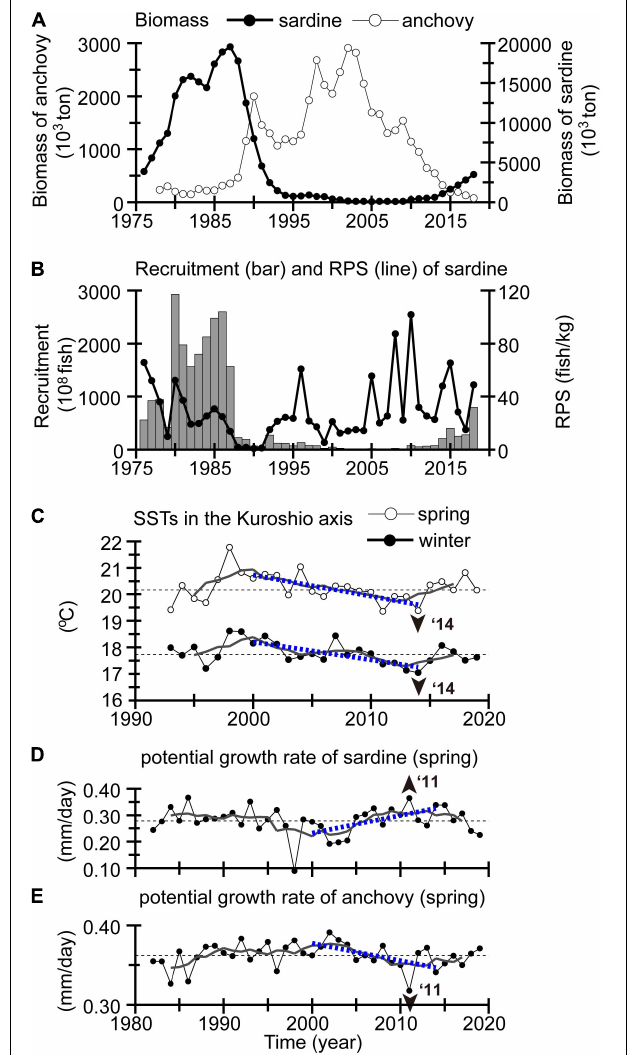
FIGURE 10 | (A) Biomass of the Pacific stock of Japanese sardine (closed circles) and anchovy (open circles). (B) Recruitment (bar chart) and RPS (line graph) of sardine. (C) SSTs during winter (closed circles) and spring (open circles) averaged for the Kuroshio area from 130 to 160 ◦ E with a stream width of ± 50 km centered at the Kuroshio axis. Potential larval growth rate of (D) sardine and (E) anchovy in spring averaged for the green box